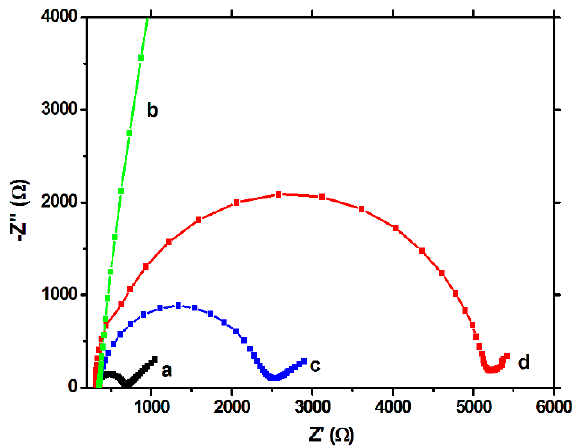
Figure 4. EIS spectra (50 frequencies) on the BDDE in 10 mM [Fe(CN) 6 ] 3 − /[Fe( CN)6 ] 4 − in 0.02 M PBS, on: ( a ) the unmodified electrode, ( b ) after electropolymerization, ( c ) after template removal (incubation for 30 min, under stirring, in NaOH 0.1 M solution) and ( d ) after rebinding of CFX (incubation for 30 min, under stirring, in 1 µM CFX solution).